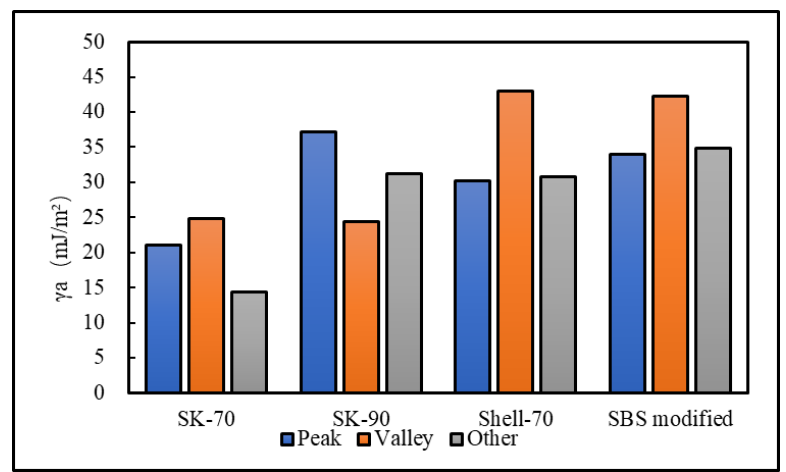
Figure 9. Surface energies of the different regions of the original asphalts.